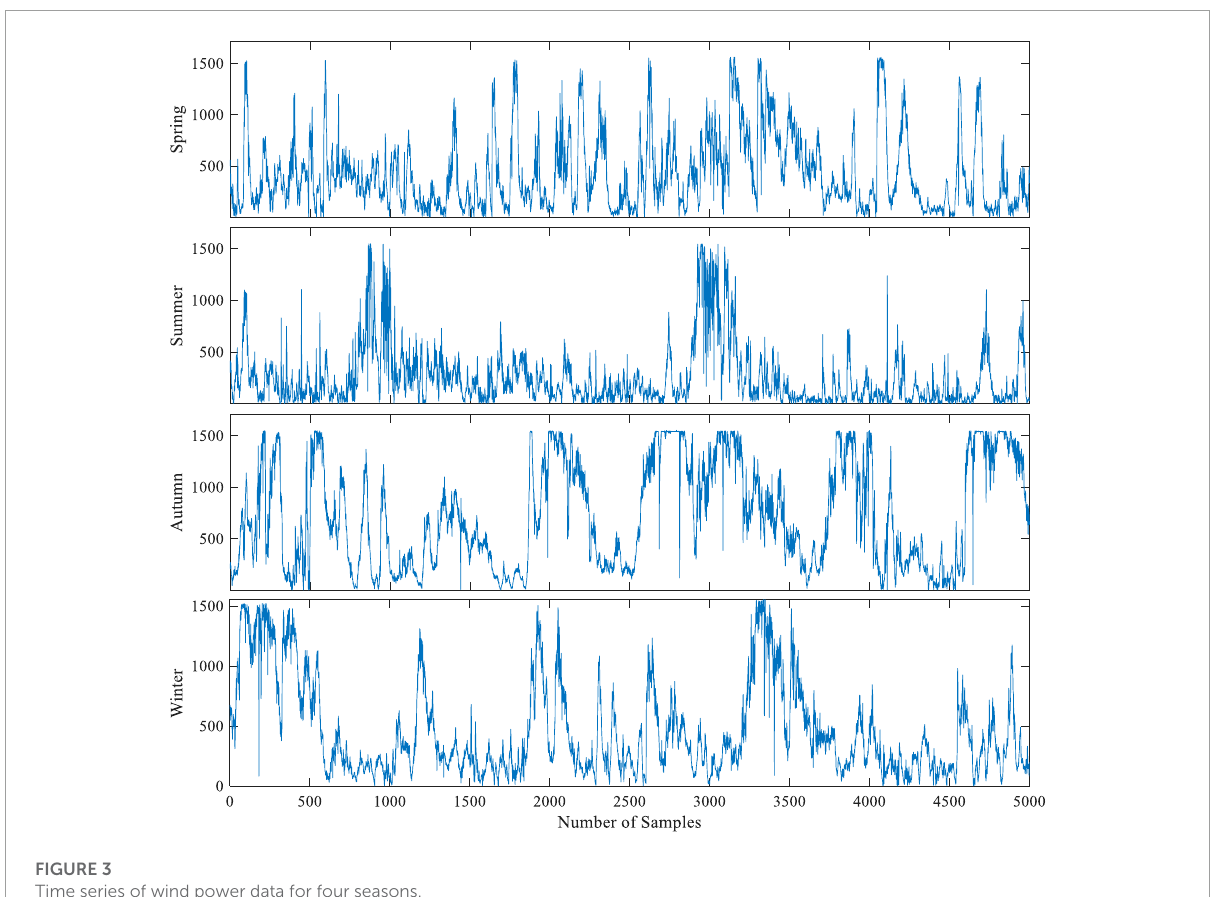
FIGURE 3 Time series of wind power data for four